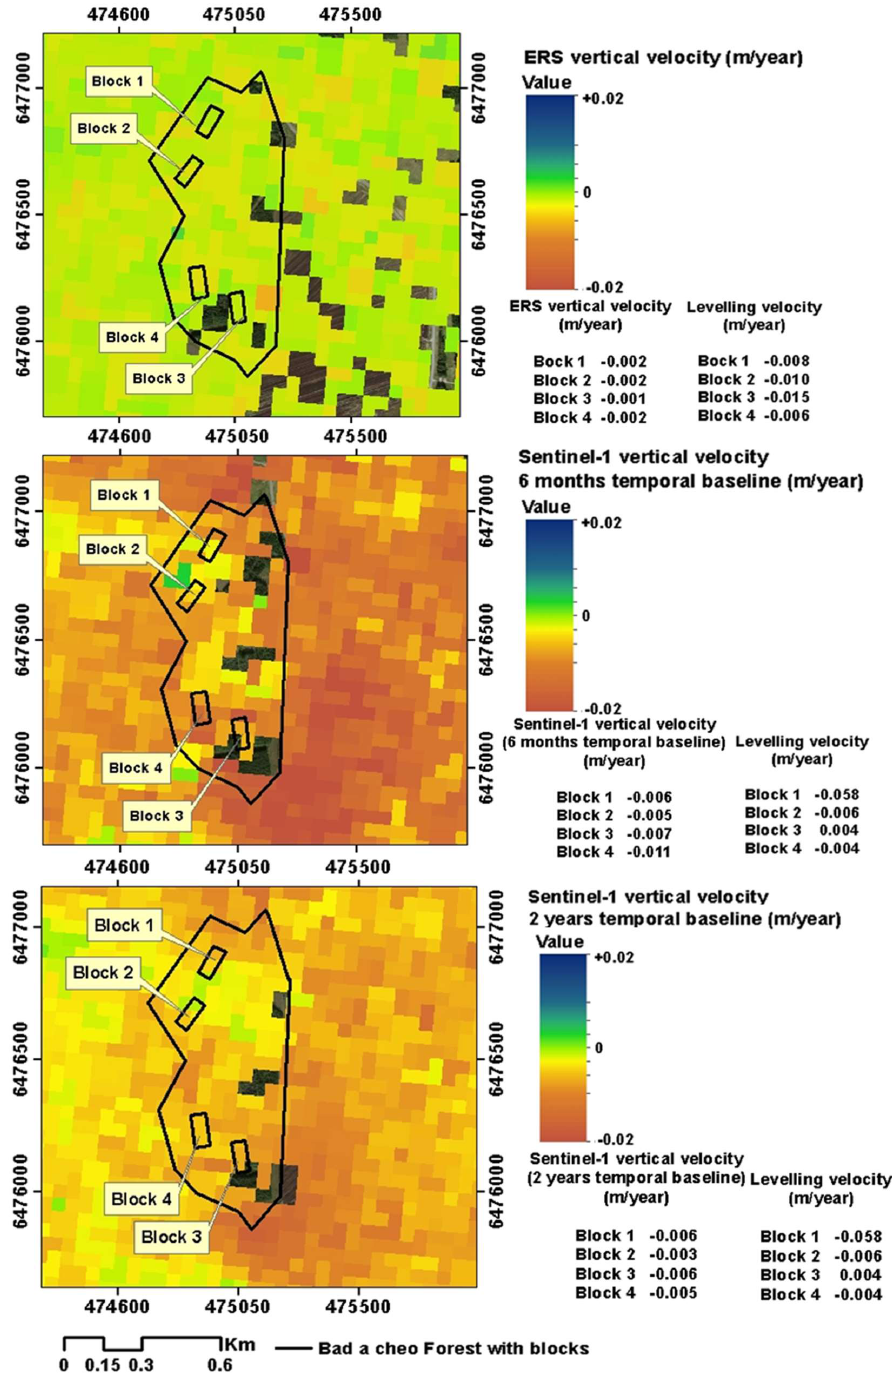
Figure 11. ISBAS vertical velocities (m/year) maps with levelling benchmarks overlaid. ( a ) ERS ISBAS vertical velocity map; ( b ) Sentinel-1 ISBAS vertical velocity map (m/year) (six-month temporal baseline); ( c ) Sentinel-1 ISBAS vertical velocity map (m/year) (two-year temporal baseline). Projection: WGS_1984_UTM_Zone 30.